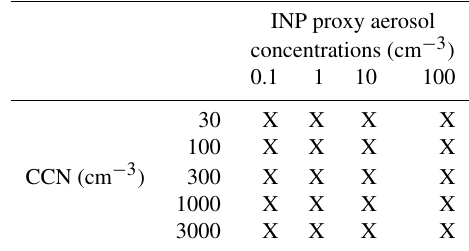
Table 1. Model simulations that are run for different CCN and INP proxy aerosol concentrations. Please note that INP proxy aerosol concentrations denote dust–bio particle number concentrations with particle size >0.5µm for use in the parameterization of DeMott et al. (2015), as described in